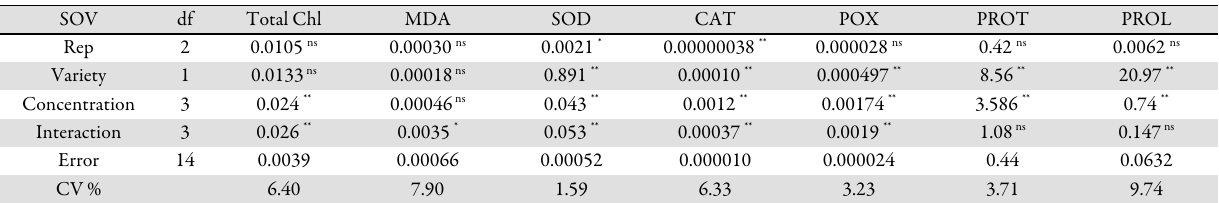
Table 2. Analysis of variance on total Chl, MDA, SOD, CAT,POX, protein and proline of canola genotypes treated by SA in second day SOV